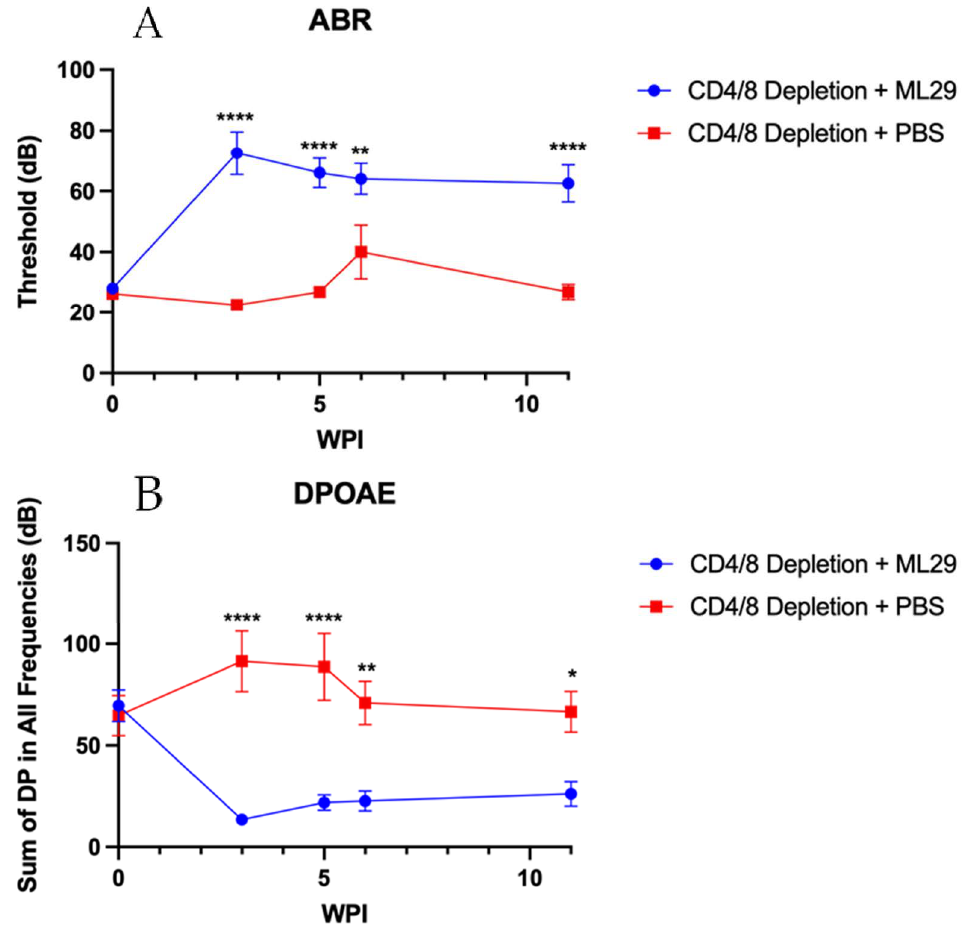
Figure 3. Hearing loss occurs in a mechanism independent of CD4 and CD8 T cells during ML29 infection. ABR ( A ) and DPOAE ( B ) were performed on the survivors of infection through 11 wpi. n = 10 Depletion + ML29; n = 8 Depletion + PBS. Data presented as mean ± SEM. * p < 0.05, ** p < 0.01, **** p < 0.0001.